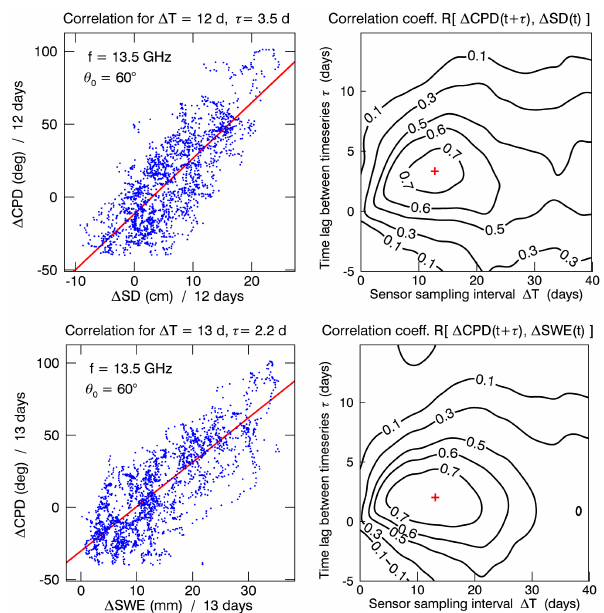
Figure 17. Left panels: correlation between (cid:49) CPD and changes in snow depth (cid:49) SD (top panel) and (cid:49) SWE (bottom panels) within a sampling interval of (cid:49)T = 12 and 13 days. The time t + τ when the CPD difference was obtained is shifted by τ = 3.5 days (top panels) and τ = 2.2 days (bottom panels) vs. the time t when the snow depth difference (cid:49) SD was obtained because the maximum CPD was al- ways observed after fresh snow has already settled. Right panels: contour plots of the Pearson correlation coefficients R for different pairs of (cid:49)T and τ . The red cross marks the pair ( (cid:49)T , τ ) with the highest correlation coefficient R